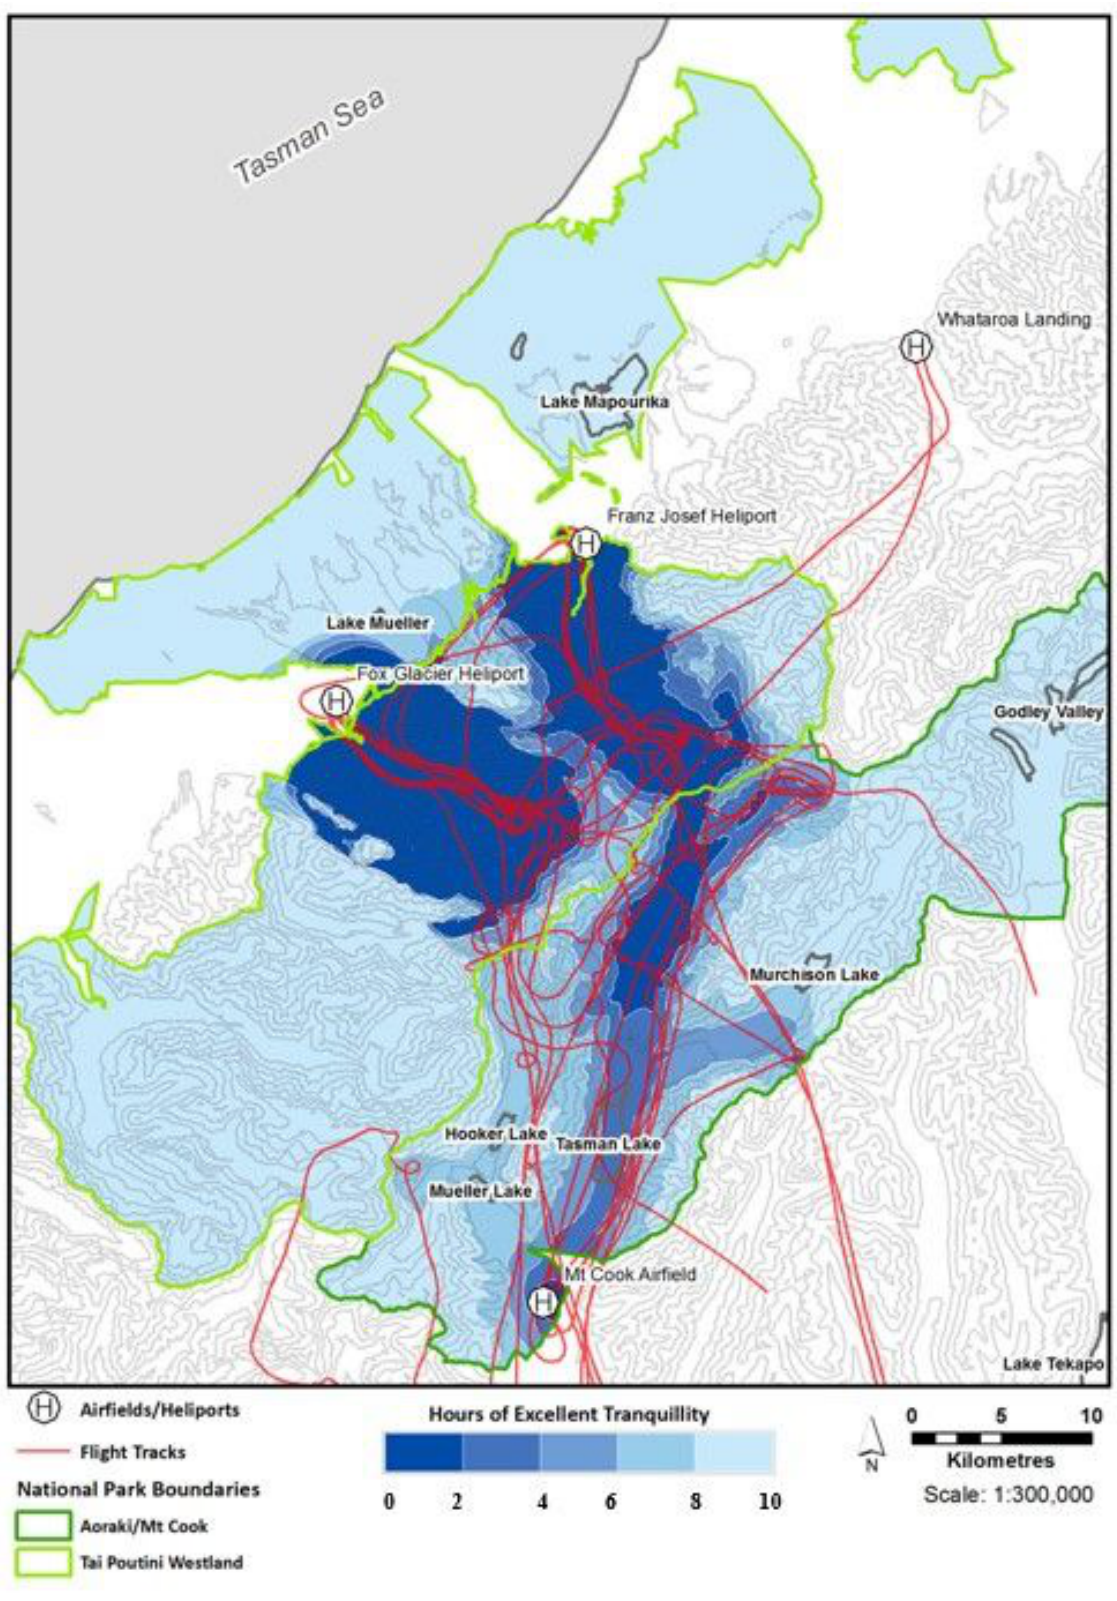
Figure 6: Tranquillity contour map showing hours of excellent tranquillity (TR ≥